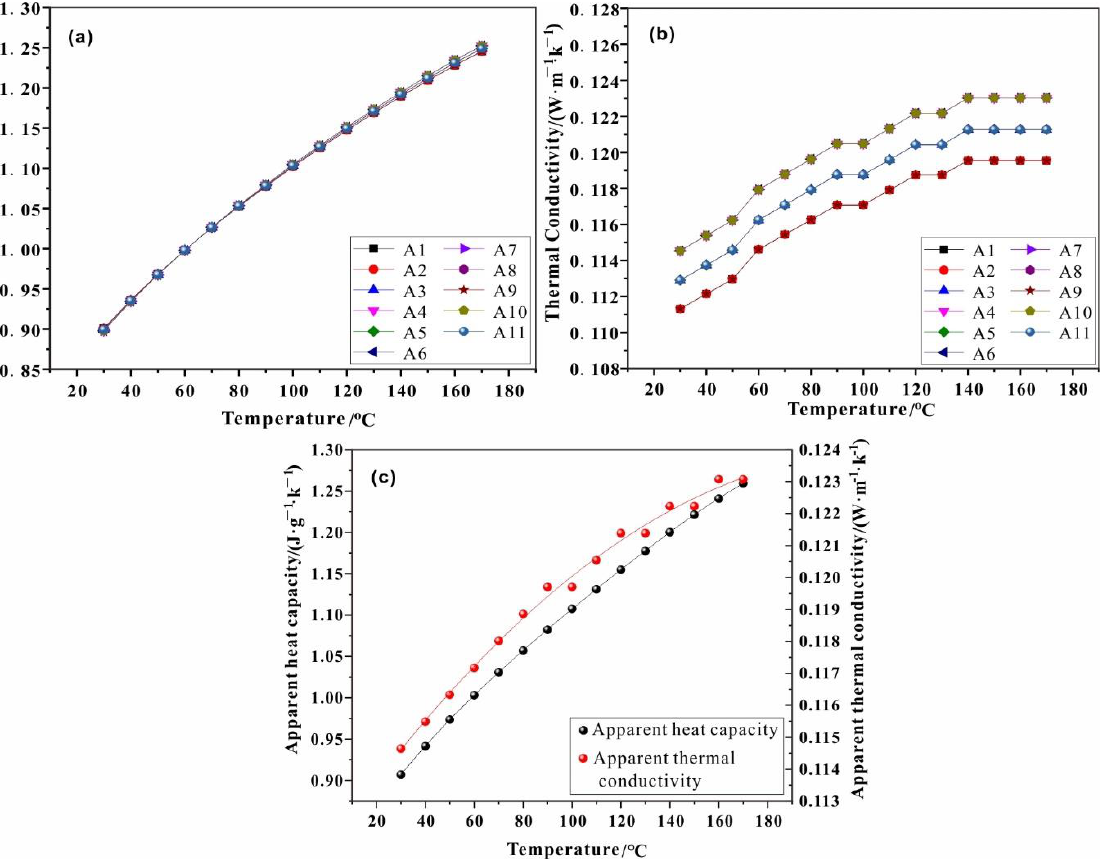
Figure 4. ( a ) Determination curve of apparent specific heat capacity of PS; ( b ) apparent thermal conductivity measurement curve of PS; ( c ) curve of specific heat capacity and thermal conductivity of DB.